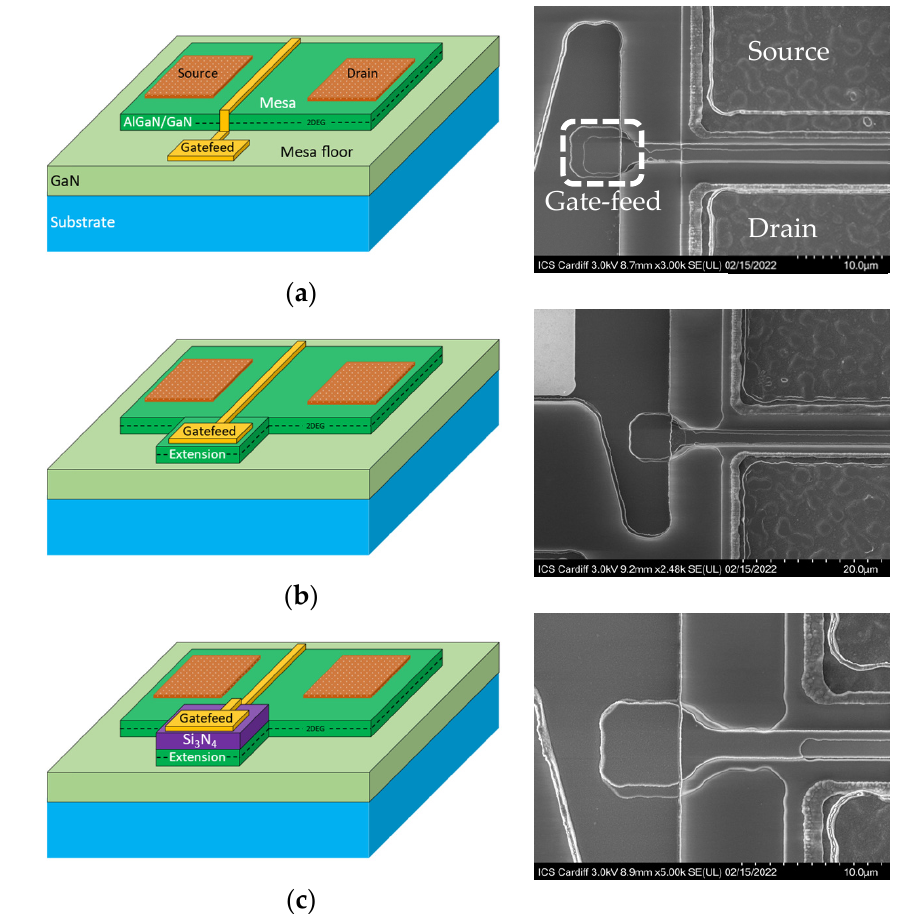
Figure 3. Three fabricated devices 3D visualization and scanning electron microscope (SEM) images, conventional ( a ), planar ( b ) and elevated by Si 3 N 4 ( c ).